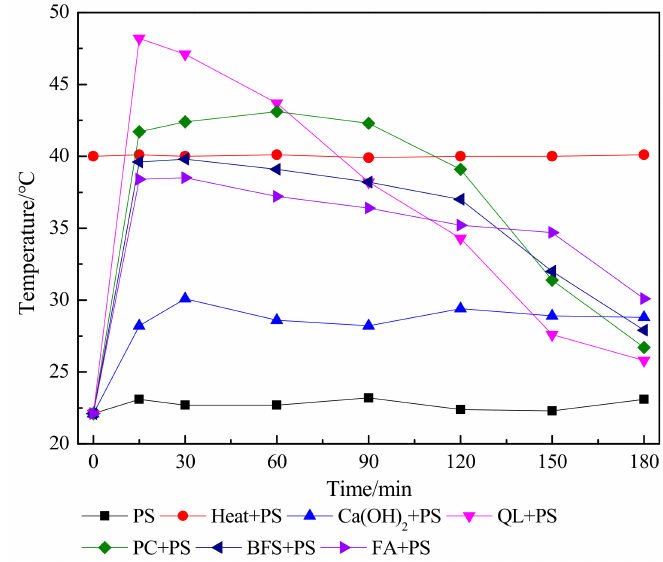
Figure 5. Temperature measurements during the 3-h mixing period in all reactions amended with persulfate. See Table S3 for the treatment abbreviations. Persulfate (PS); Quick lime (QL), Portland cement (PC), blast-furnace slag (BFS), and fly ash